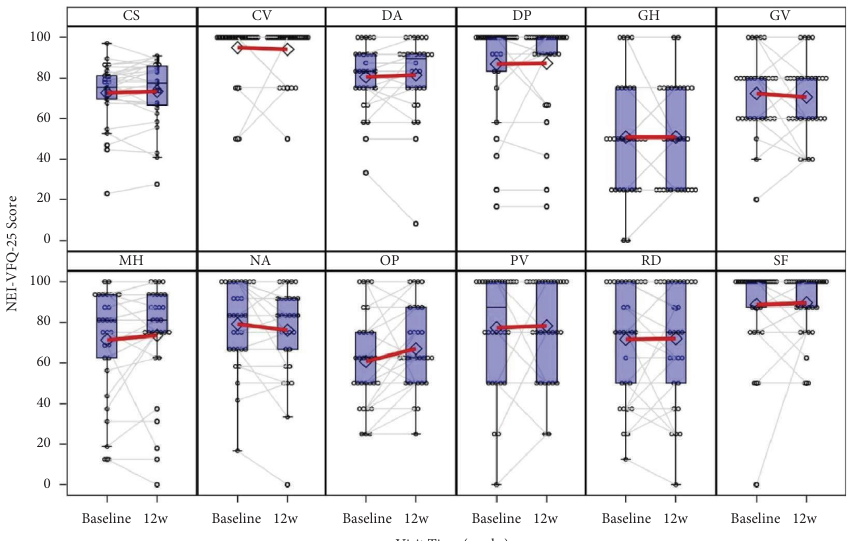
Figure 2: NEI-VFQ-25 domain scores by time with individual profles. Abbreviations: CS, composite score; CV, color vision; DA, distance activity; DP, dependency; GH, general health; GV, general vision; MH, mental health; NA, near activity; OP, ocular pain; PV, peripheral vision; RD, role difculty; SF, social